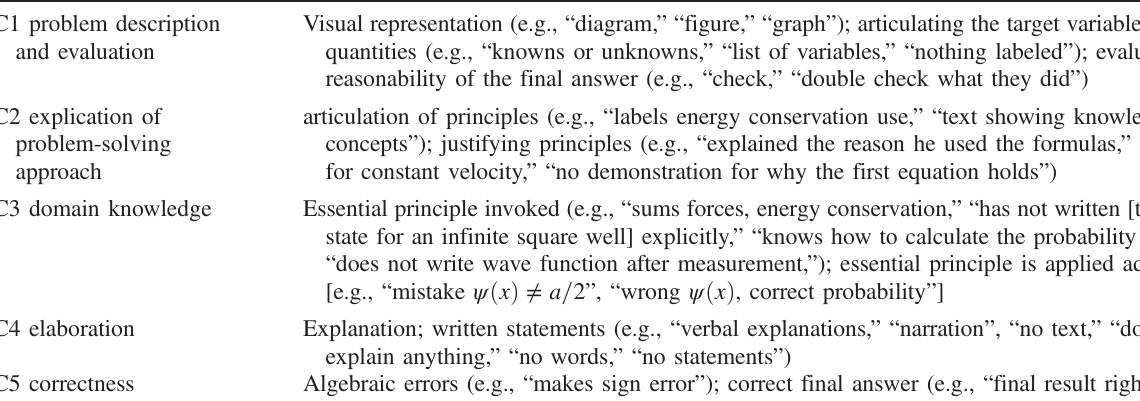
TABLE III. Sample features sorted into clusters and sample citations. Visual representation (e.g., “ diagram, ” “ figure, ” “ graph ” ); articulating the target variables and known quantities (e.g., “ knowns or unknowns, ” “ list of variables, ” “ nothing labeled ” ); evaluation of the reasonability of the final answer (e.g., “ check, ” “ double check what they did ” )